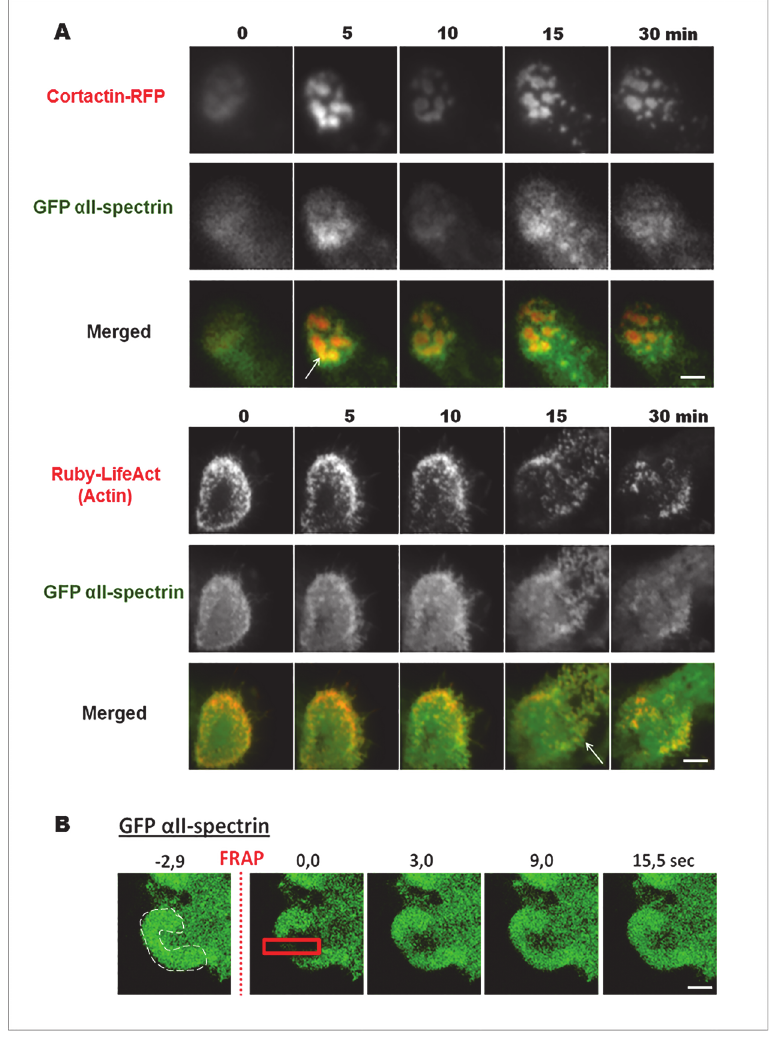
Fig 3. GFP α II-spectrin dynamics in invadosomes. (A) Extracted images from time series (min) from representative observations by TIRF microscopy of living SrcY527F-MEF cells expressing full length of α II- spectrin fused to GFP an invadosome marker fused to RFP, cortactin, or the actin marker Ruby-LifeAct. Ten observation fields were analyzed from at least three different experiments. GFP- α II-spectrin accumulated in isolated or invadosome rings, during their expansion or disorganization. These data link α II-spectrin with the intense actin remodeling associated with invadosome dynamics. (B) To confirm this point, net flux of GFP- α II-spectrin was analyzed by FRAP technology. After a 2.9 sec photobleaching in the red square, α II-spectrin fluorescence starts to reappear after only 3.0 sec, and total recovery of the fluorescence in the photobleached area occurred at 15.0 sec. The invadosome ring is identified by a white dash line here in a portion of cell in the first time. Relevance of the results were obtained by analyzing 10 observation fields from at three different experiments. Scale bar: 3 μ